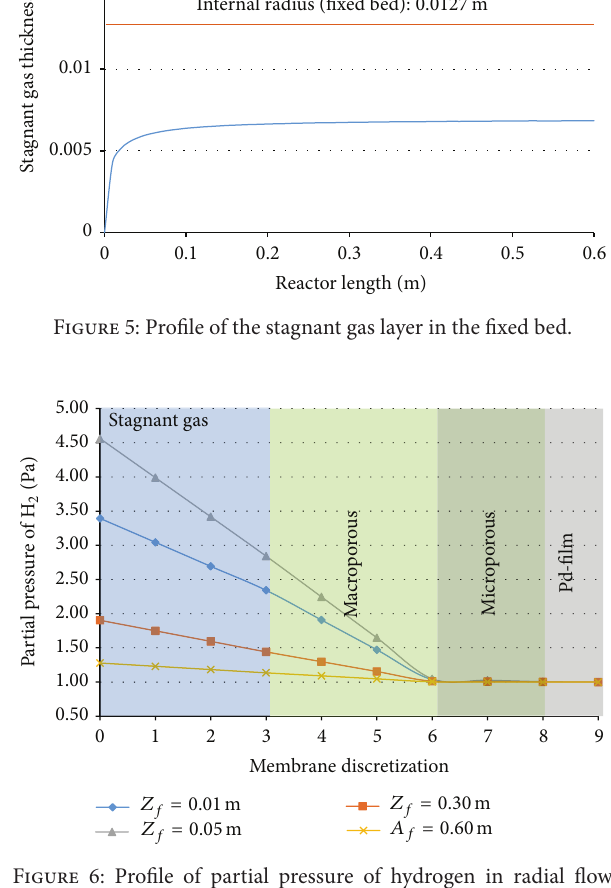
Figure 6: Profile of partial pressure of hydrogen in radial flow through the different